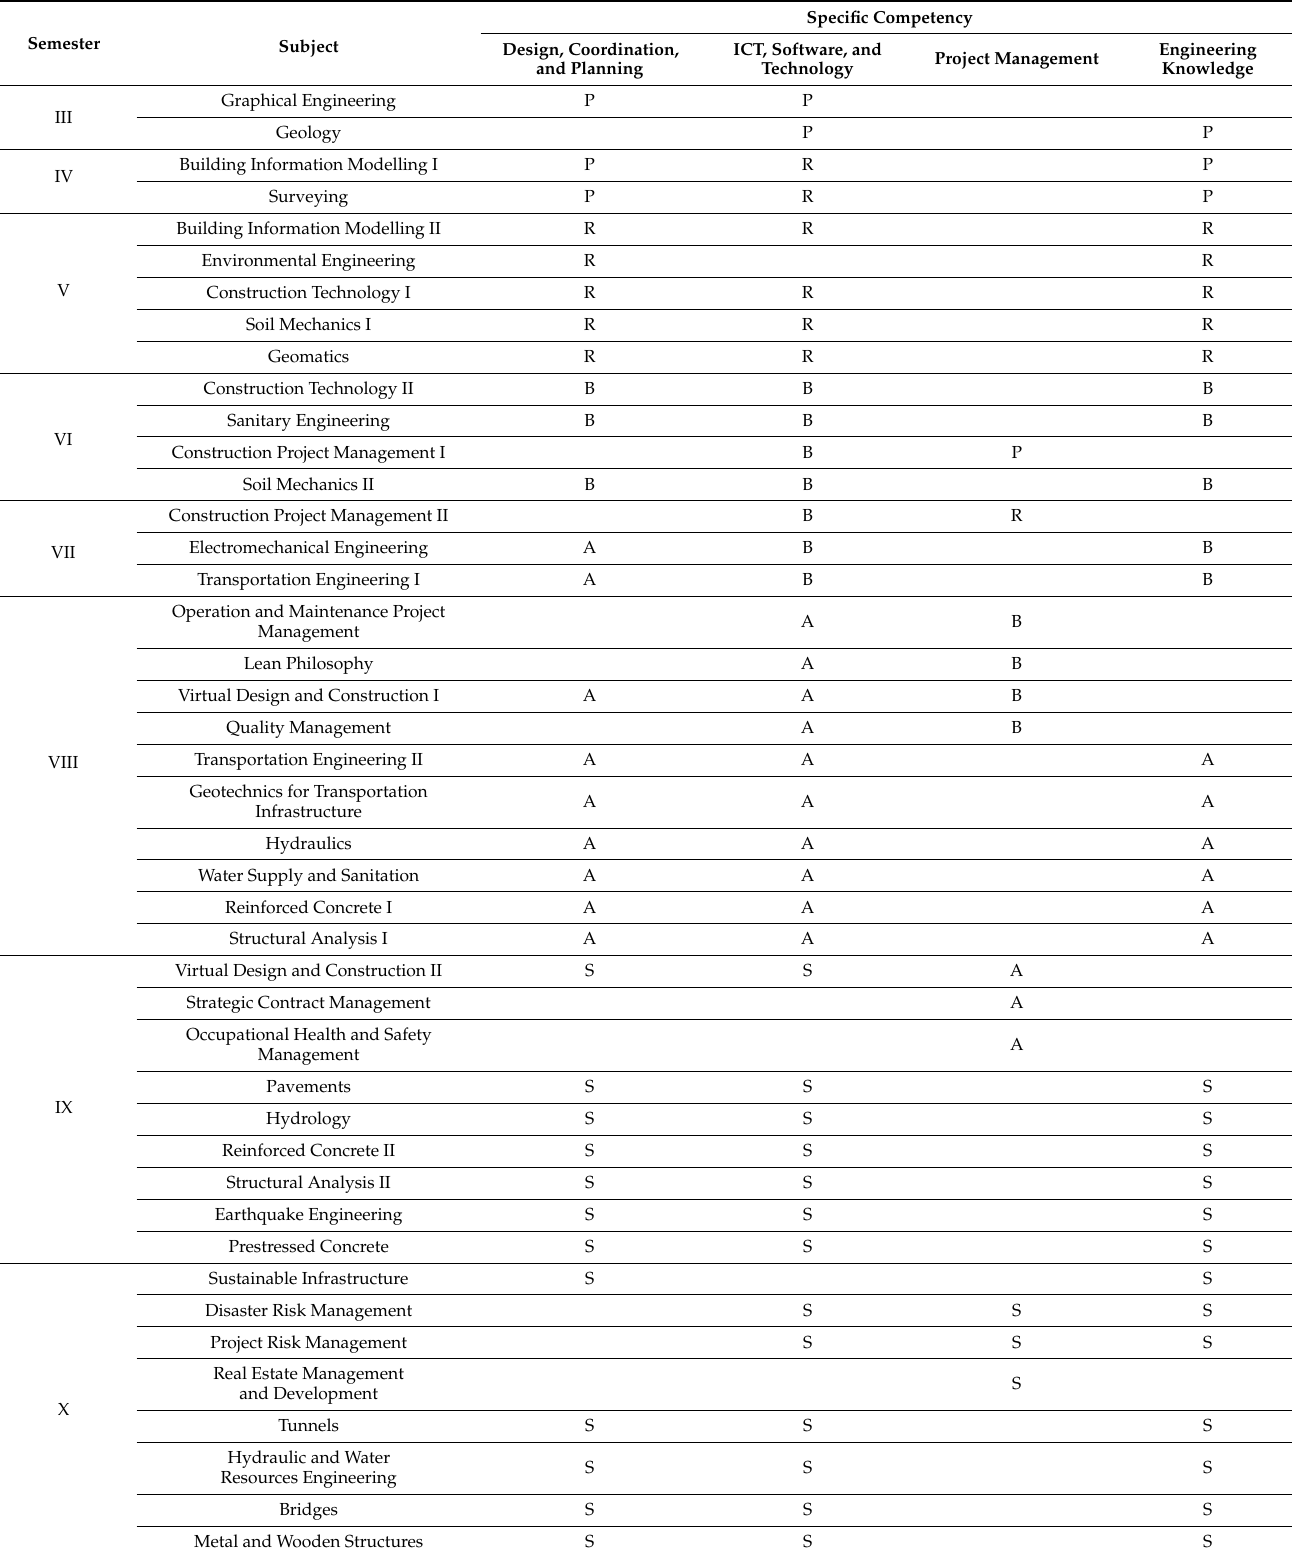
Table 11. Interrelationship matrix with proficiency levels between subjects and specific competencies from the civil engineering program 3